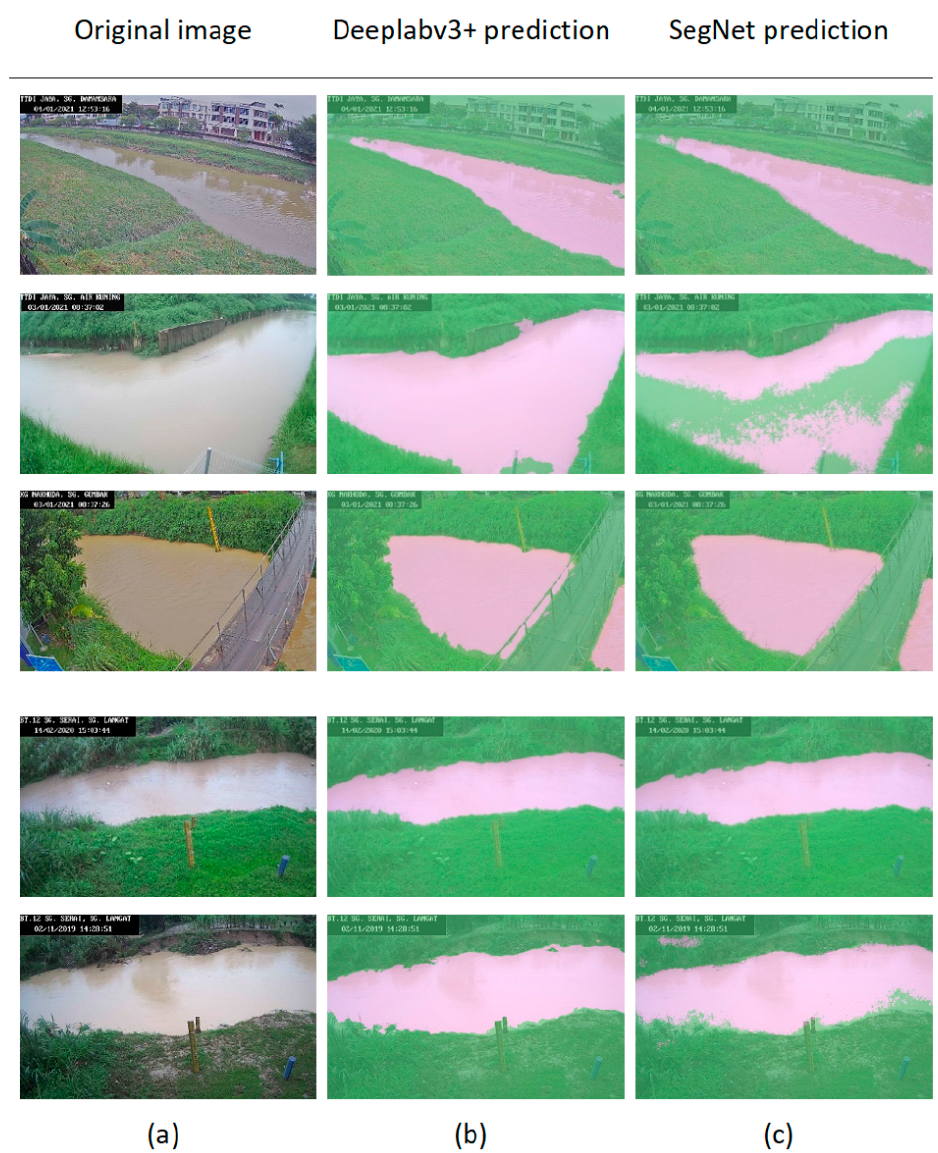
Figure 11. Visualization and comparison of segmentation results during inference phase. ( a ) Original image. ( b ) DeepLabv3+ prediction. ( c ) SegNet prediction.